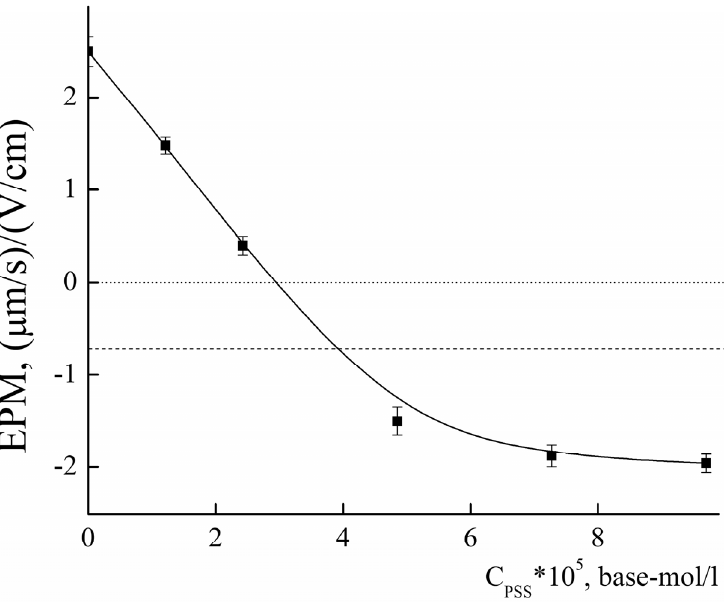
Figure 8. The dependence of EPM of PLAMs–us upon the concentration of added PSS; acetate buffer with pH 5, c = 0.01 M, 25 ◦ C.